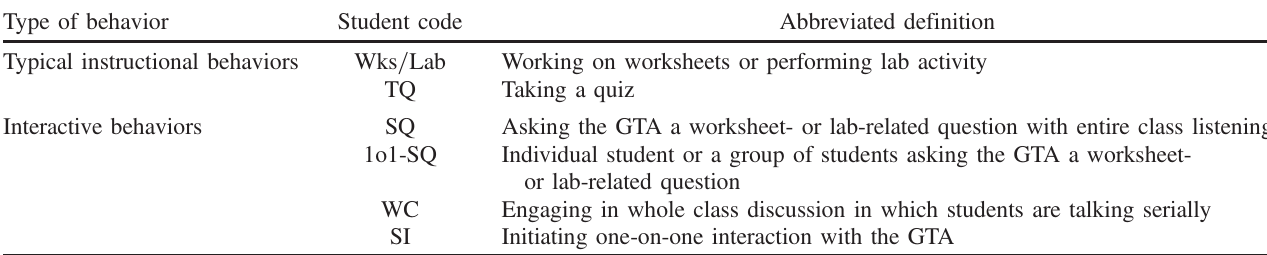
TABLE III. Definitions for codes that describe student